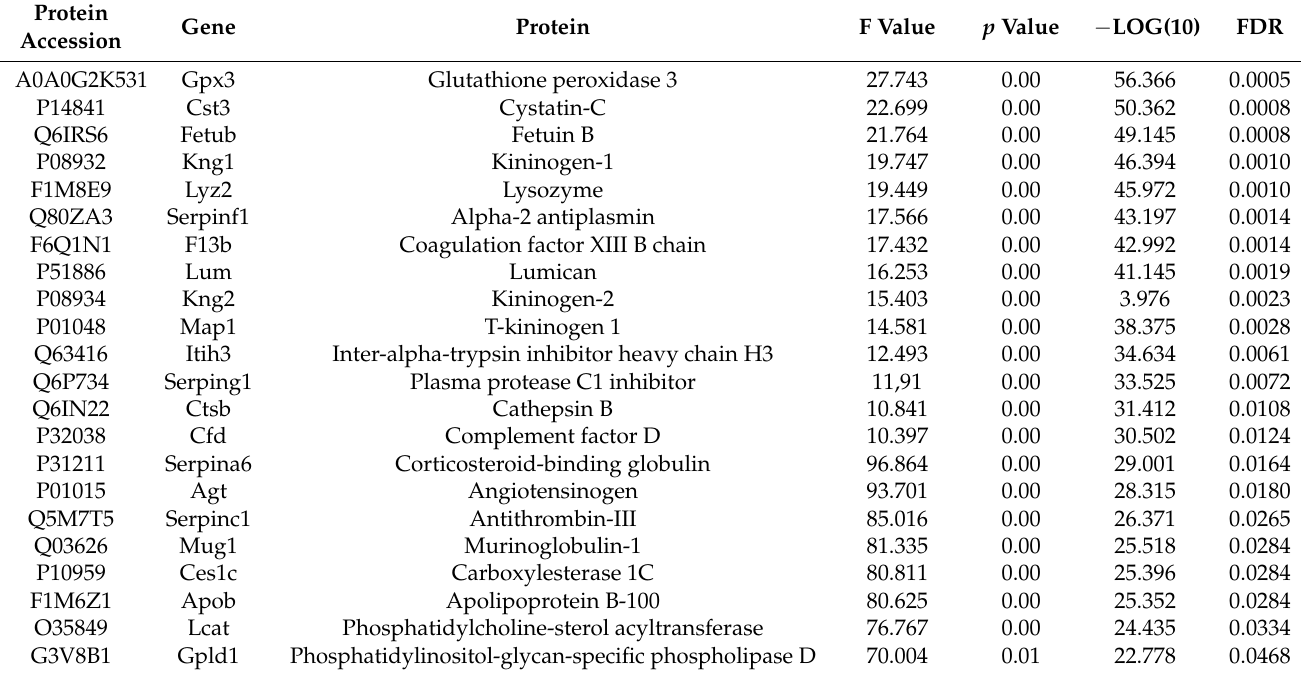
Table 2. Plasma proteins differentially expressed among the experimental groups analyzed by